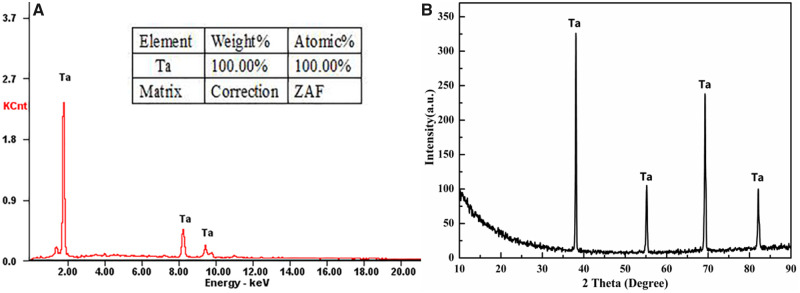
(A) EDS survey spectra and (B) XRD patterns of the SiC substrate and ta coating.